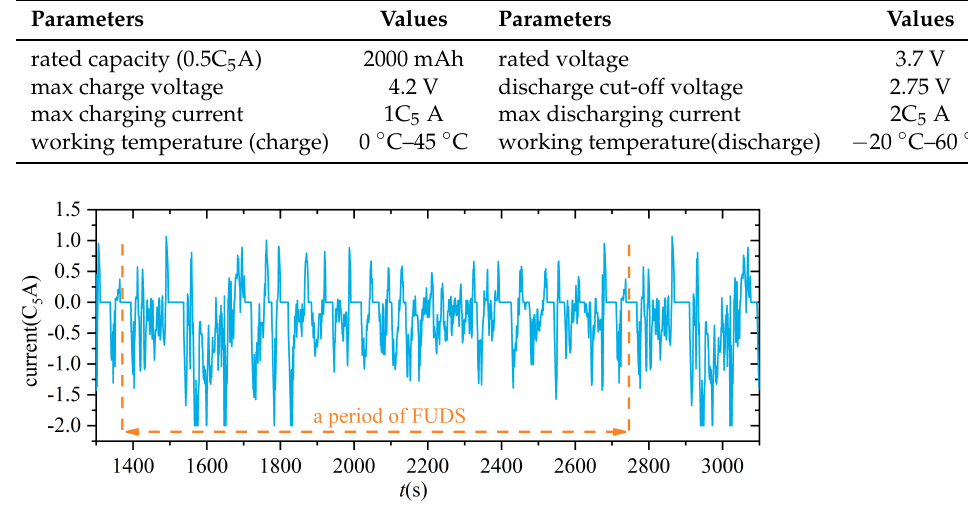
Figure 6. Current profile of a single period in